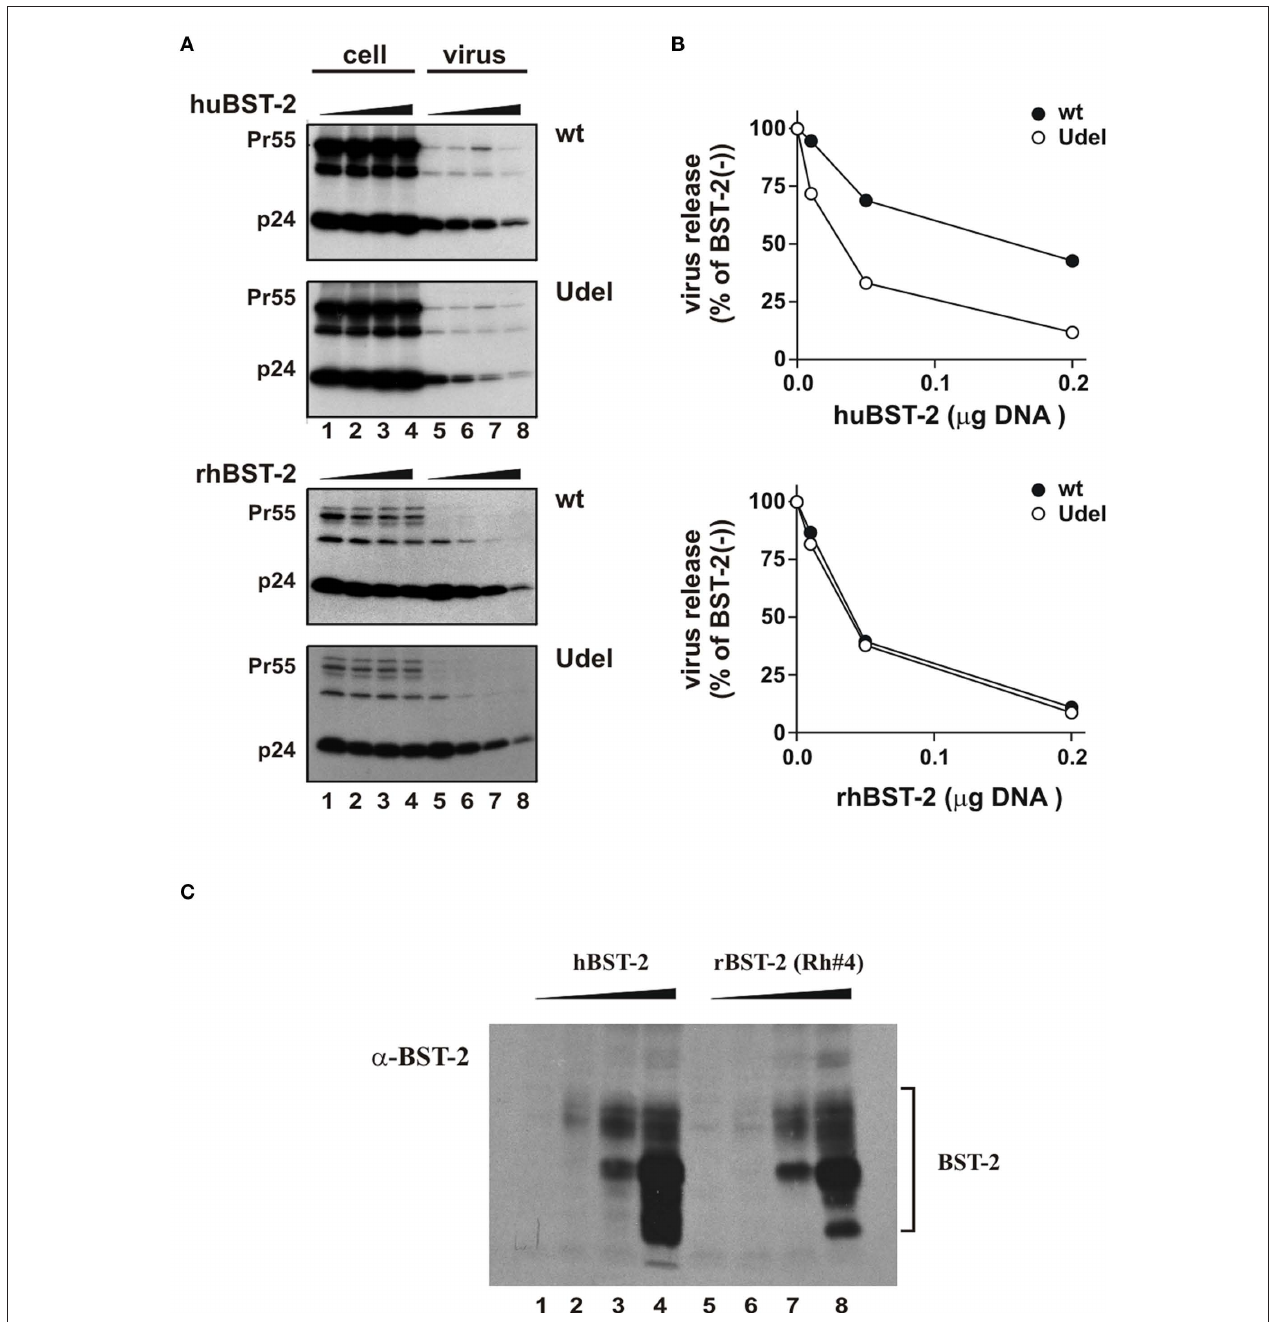
The amount of p24 released in the absence of BST-2 relative to the total intra- and extracellular Gag protein was defined as 100%. Virus release in the presence of increasing amounts of BST-2 was calculated accordingly and the results were plotted as a function of transfected BST-2 DNA. (C) Expression of BST-2 was analyzed by immunoblotting. 293T cells were transfected with 0 (lanes 1 and 5), 0.01 (lanes 2 and 6), 0.05 (lanes 3 and 7), or 0.2 μg (lanes 4 and 8) of human BST-2 or rhesus BST-2 as in (A) . Total amounts of transfected DNA were adjusted to 5 μg using empty vector DNA as appropriate. Whole cell lysates were prepared 24 h after transfection and subjected to immunoblot analysis using a BST-2 specific antibody as described in Figure 1B